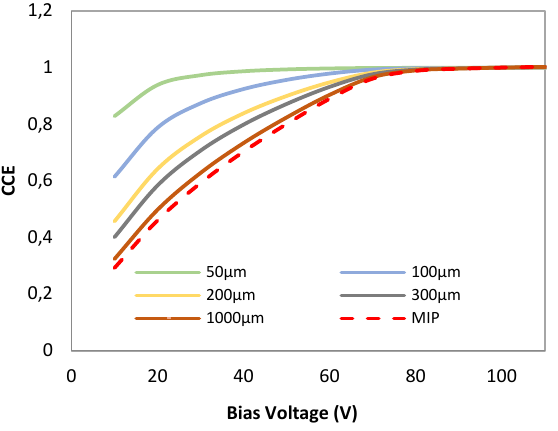
Fig. 9. Charge collected from Am-241 encapsulated source in ADC counts (a) and in energy